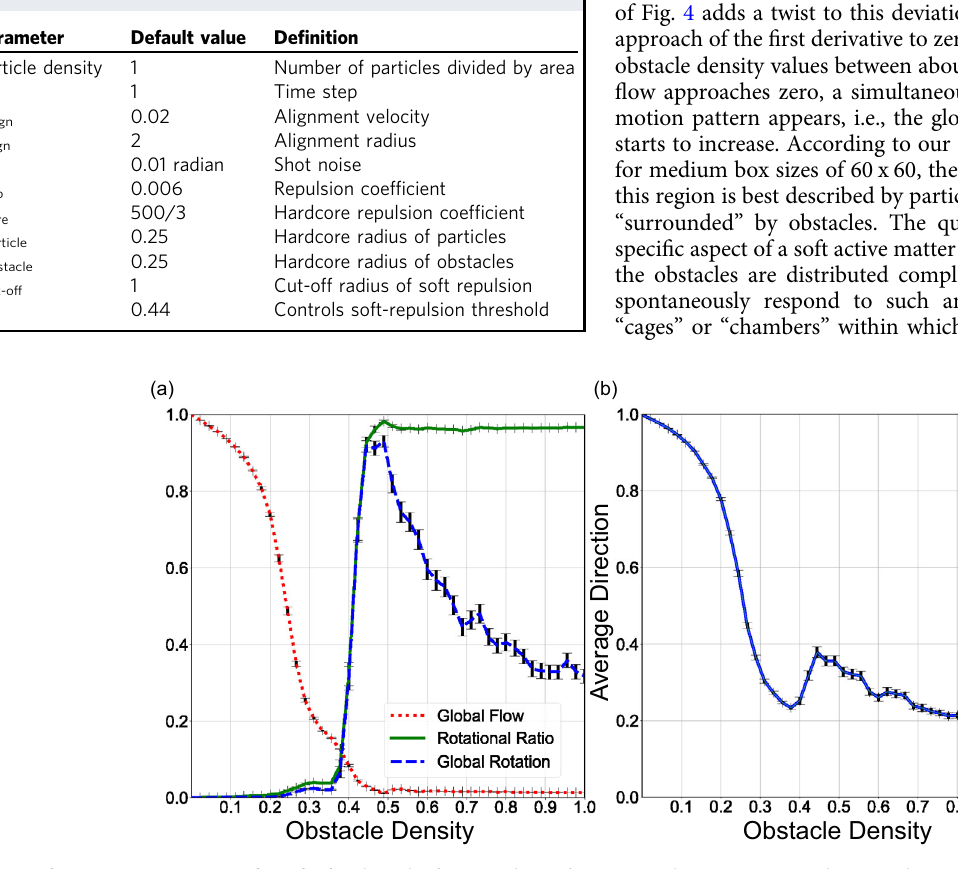
Fig. 4 Order parameters versus obstacle density. The fi gure is drawn for 160 simulations in 60 x 60 boxes with periodic boundary conditions and parameters being the same as in Table 1. The error bars denote the standard error of the averages. a The red dotted line indicates the order parameter of the directional motion. Directional motion seems to be the dominating/only pattern of motion till obstacle density 0.3. In the interval 0.3 – 0.45, the particles are in a mixed state which we associate with a labyrinth-like pattern. In parallel, the Rotational Ratio (solid green line) shows that till 0.3, there is no rotation, and then in 0.3 – 0.45, particles start to rotate until nearly all of them are rotating in obstacle densities more than 0.45. The Global Rotation (blue dashed line) increases to approximately 1 at 0.45 obstacle density and then beyond approximately 0.45 decreases. The initial increase shows the emergence of a synchronised rotation state, and the decrease shows the transition from synchronised rotation to the rotation where both directions exist but with synchronisation on a local scale only. b The initial decrease of the average direction shows the loss of directionality in the motion of the particles, while the relatively sudden increase at 0.45 is due to the emergence of synchronised